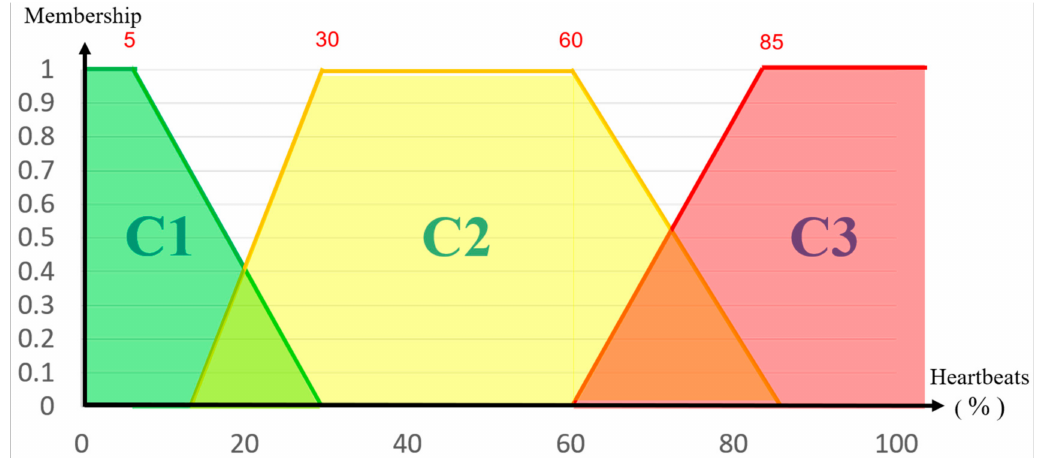
Figure 12. Fuzzy set of heart